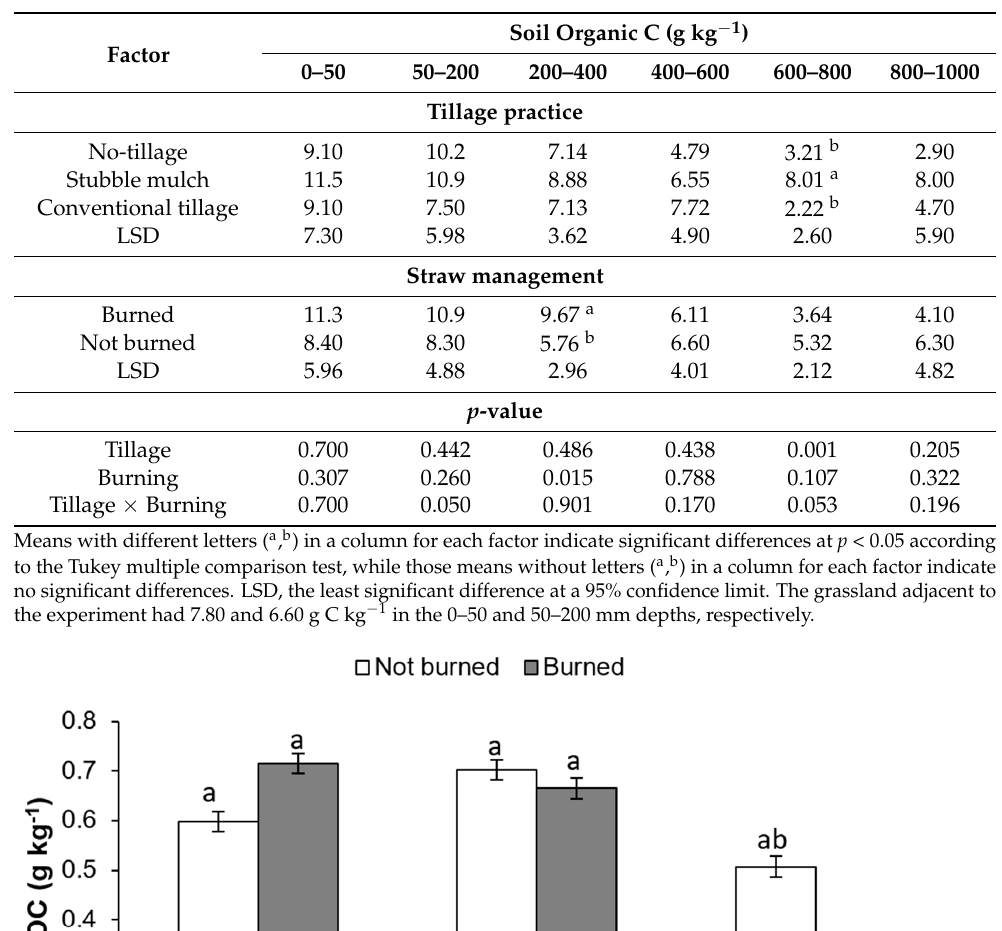
Table 2. The effect of tillage and straw management on carbon that was associated with macro-